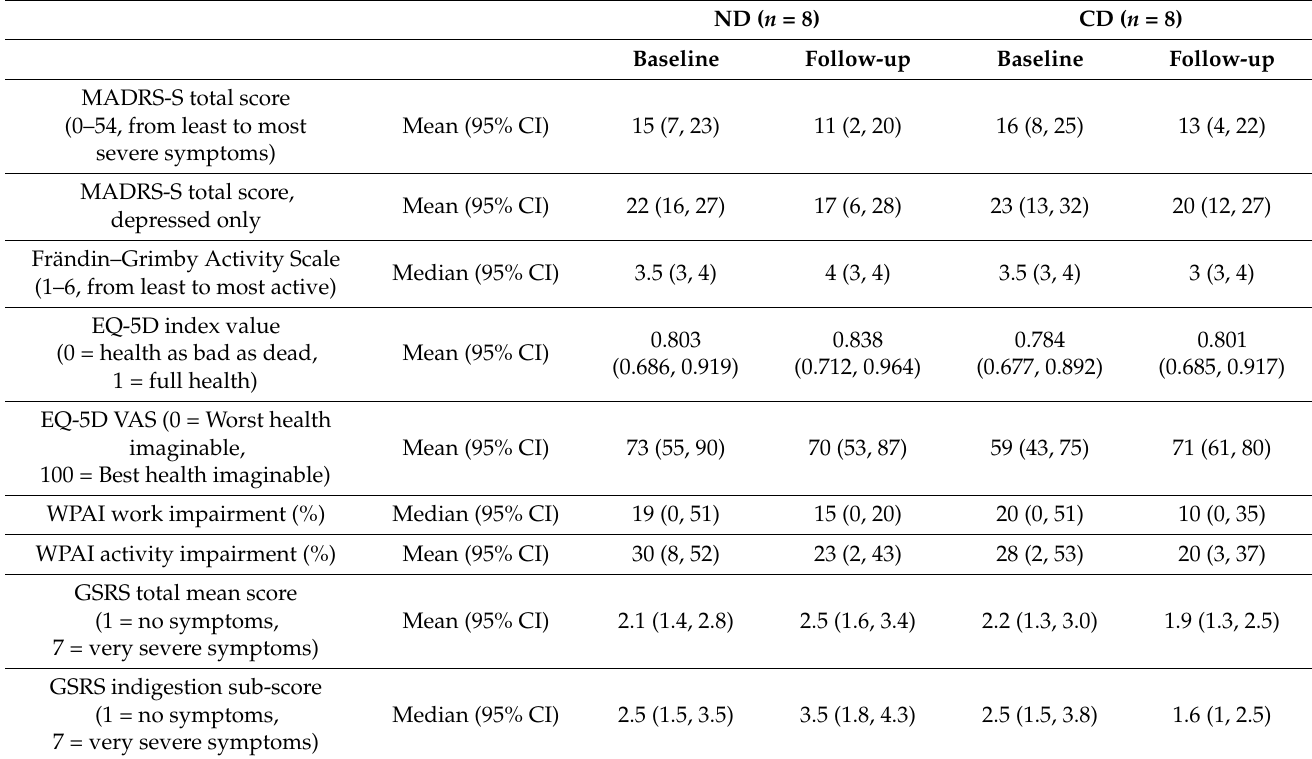
Table 4. Estimates of health-related assessments in the healthy Nordic diet (ND) and control diet (CD) groups at baseline and follow-up (8